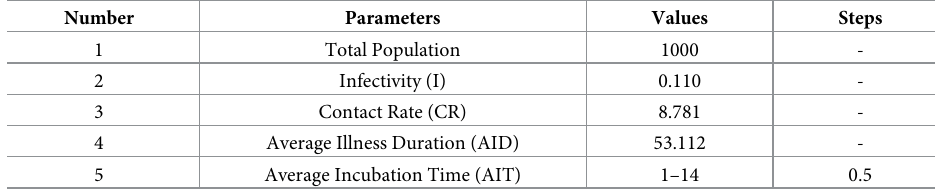
Table 7. Parameter values in sensitivity analyses